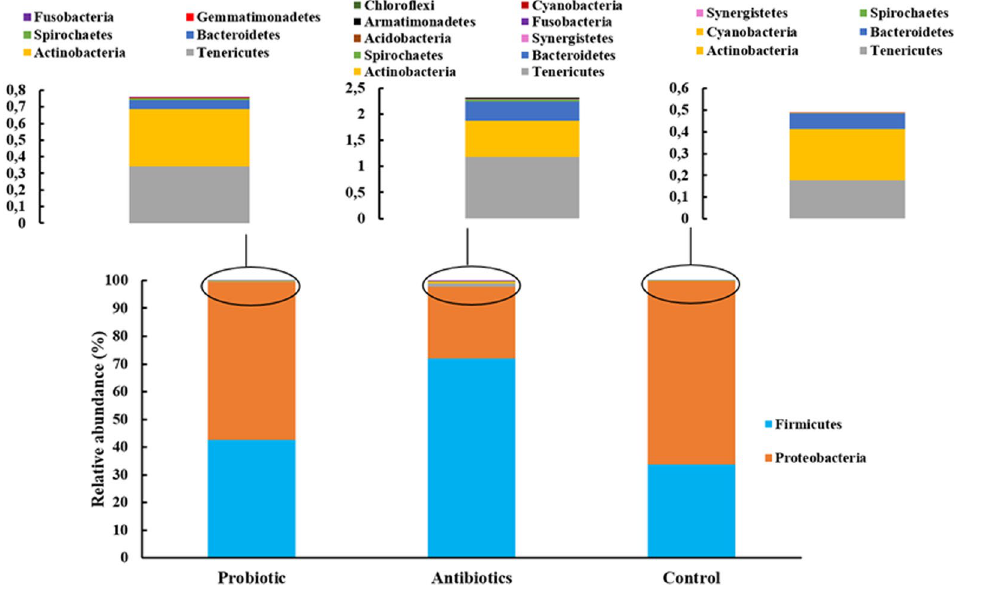
Figure 3. Phyla present in the cecum microbiome of broilers from the different treatment groups i.e. multi- strain probiotic, antibiotic combination and untreated.